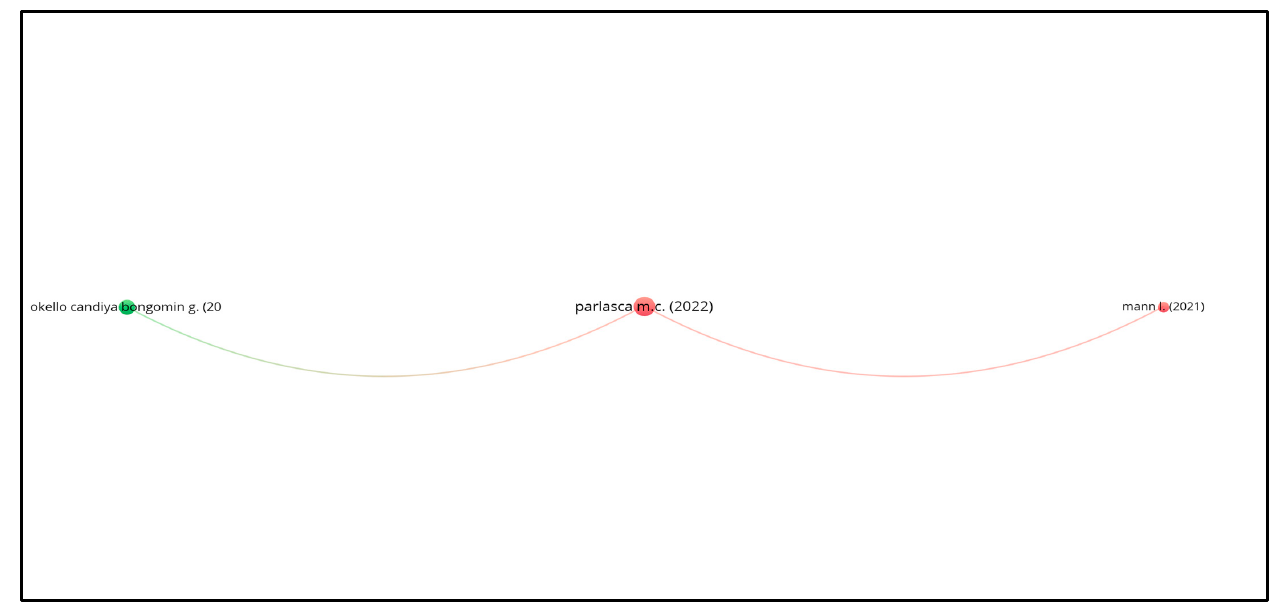
Figure 5. Network map for citations by authors. Source: Authors’ own compilation processed in VOSViewer.